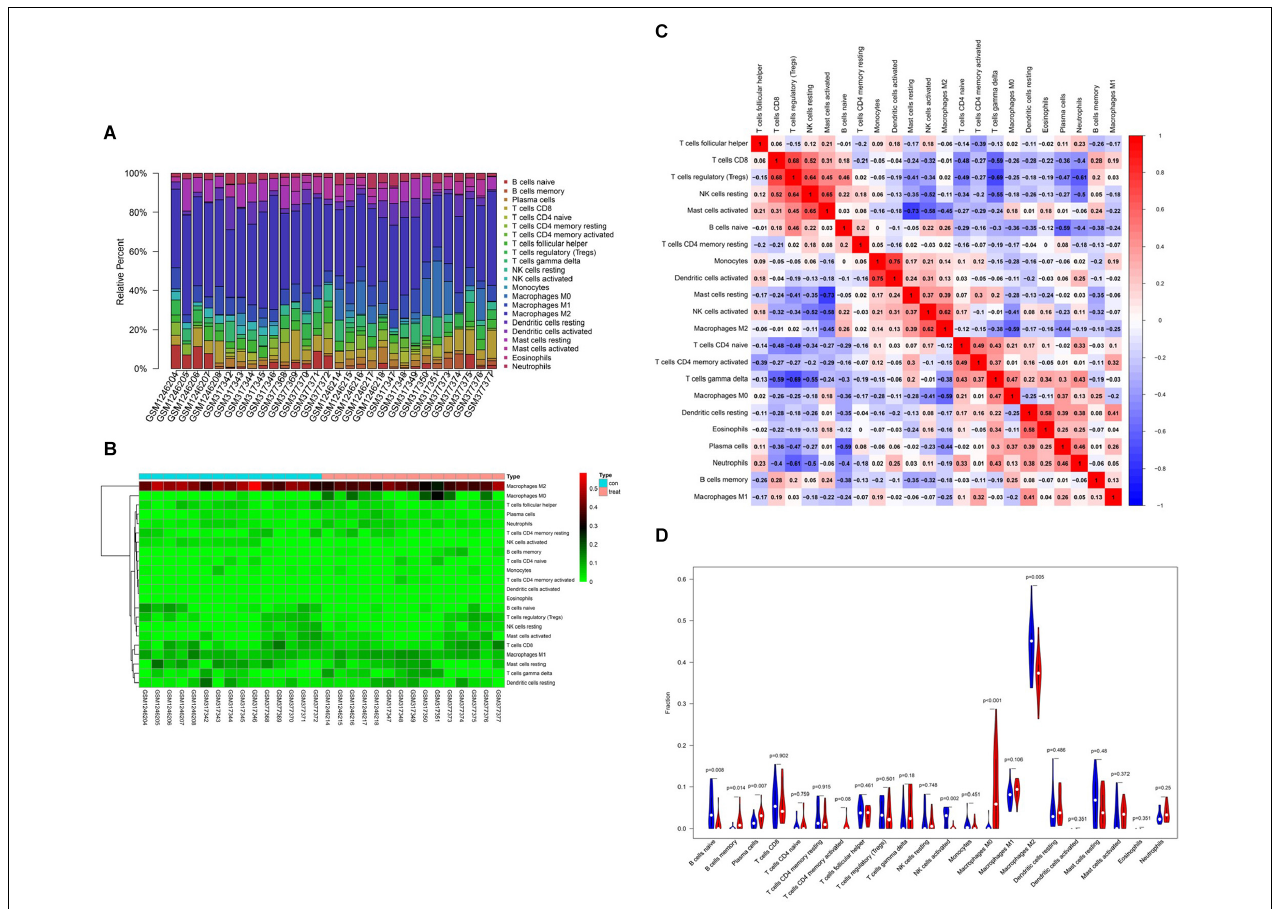
FIGURE 5 | Summary of inferred immune cell subsets between CAVD and normal controls. (A) The relative percentage of 22 subpopulations of immune cells in 30 samples from GSE13985and GSE6054 datasets. (B) The heat-map of the 22 subpopulations of immune cells. (C) Correlation analysis based on 22 immune cell subpopulations. (D) The difference of immune infiltration between VACD and normal controls. (The normal controls group was marked as blue color and CAVD group was marked as red color. P values < 0.05 were considered as statistically